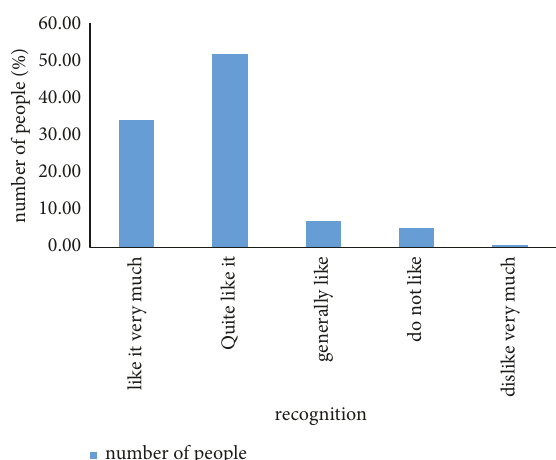
Figure 5: Recognition of the information-based teaching model.